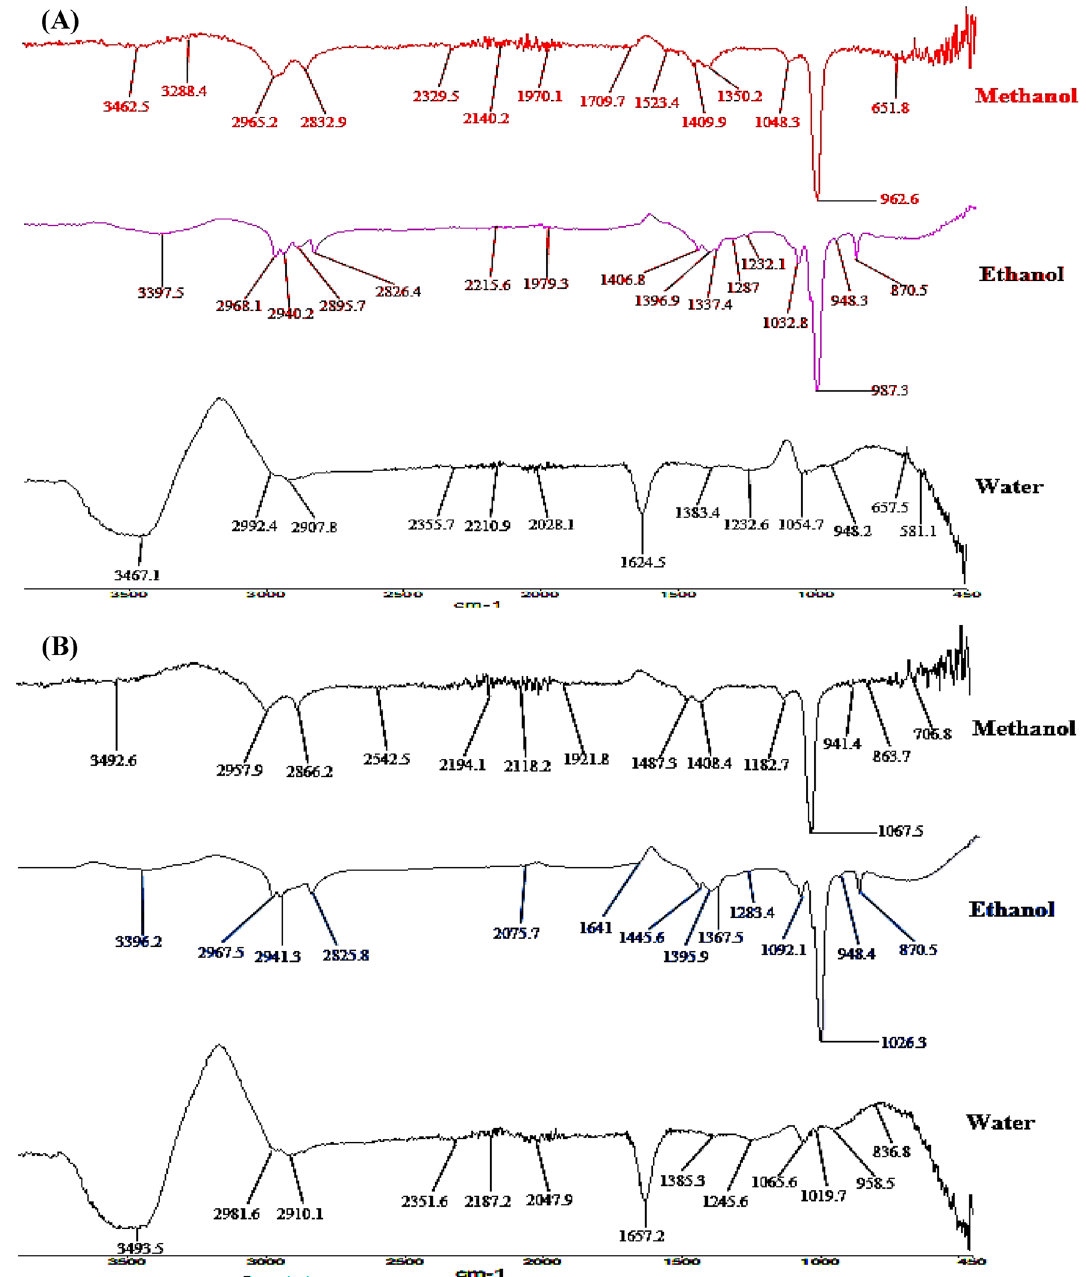
Figure 1. FTIR spectrum of different solvent extracts of seaweed ( A ) P. tetrastromatica and ( B ) G. tenuistipitata